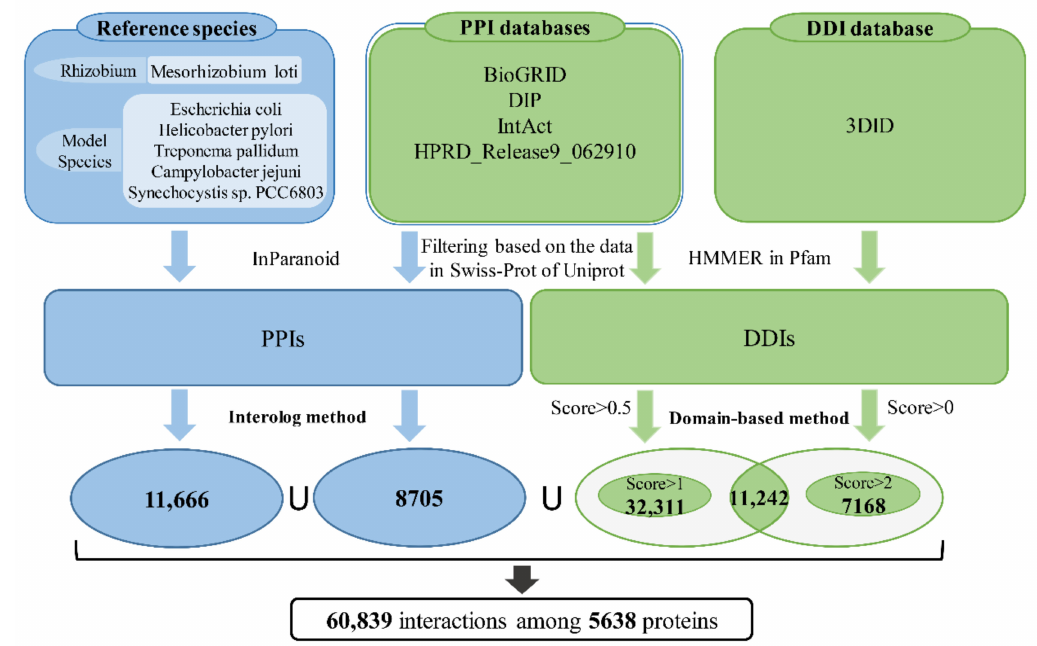
Figure 1. Flowchart for reconstructing the protein interactome of B. diazoefficiens